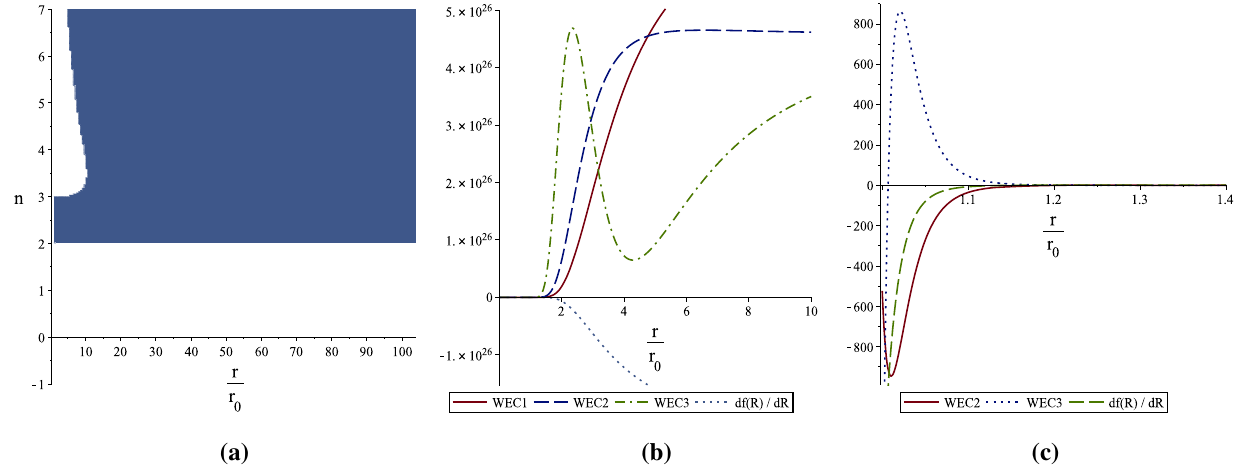
Fig. 13 In the case of c 1 = − 1, a shows the region that F < 0 and (18) are satisfied in blue. This means that the WEC is respected by the asymptotically hyperbolic wormhole solutions of the exponential grav- ity model, almost through the whole space outside the throat. In b we